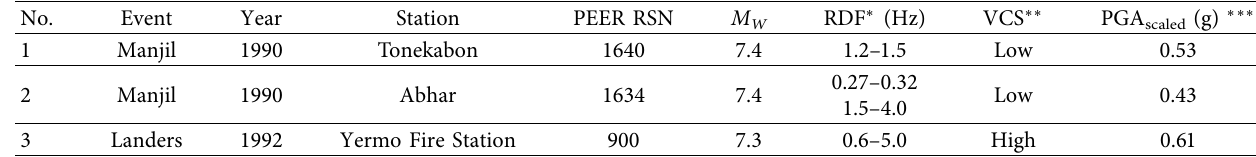
Table 2: Properties of the recorded ground motions used for the seismic response